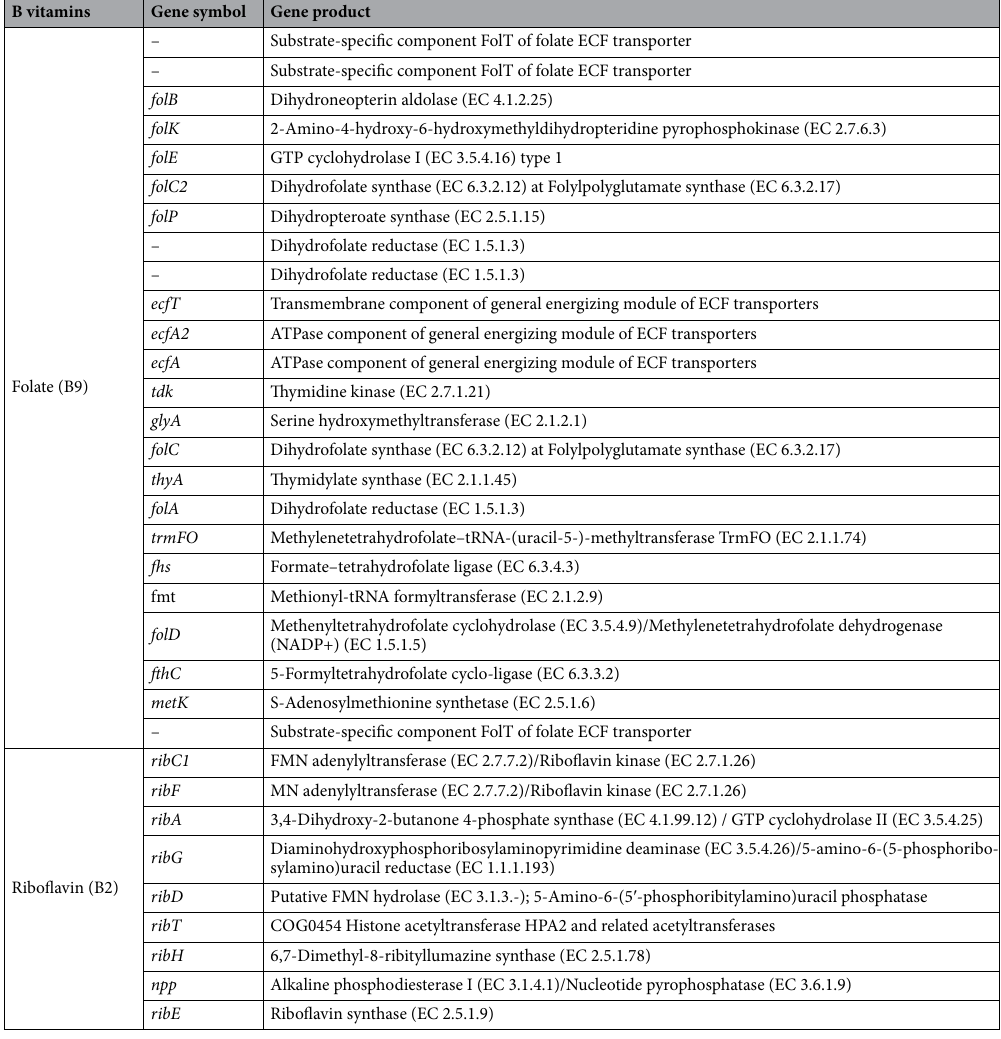
Table 5. List of putative genes in the L. plantarum ATCC 202195-A genome involved in B vitamin the import of short-chain FOS (scFOS) into the cytosol. The L. plantarum ATCC 202195-A genome also con- tains three gene clusters critical to the production of the short-chain fatty acid butyrate from acetyl-CoA. Biosynthesis of B complex vitamins. Evaluating the L. plantarum ATCC 202195-A genome for genes involved in the biosynthesis of B vitamins, revealed a complete gene cluster ( folA, folB, folC1, folC2, folD, folE, folK, folP and folQ ) that is involved in folate (vitamin B9) biosynthesis and utilization (Table 5). In contrast to L. plantarum strain WCFS1 38 , the L. plantarum ATCC 202195-A genome contains a complete riboflavin operon, including the ribA, ribB, ribH, ribE and ribG genes, required for riboflavin biosynthesis (Table 5). L. plantarum ATCC 202195-A also encodes genes involved in thiamine and biotin utilization and salvage; however, based on the genome sequences, the microbe appears incapable of de novo synthesis of either of these vitamins. Bacteriocins. The L. plantarum ATCC 202195-A genome encodes three plantaricin specific operons, includ- ing the regulator operon plnABCD, the bacteriocin operon plnEFI and the transport operon plnGHTUVW , which are required to produce the class IIb bacteriocins, plantaricin plnEF and plnA. Bacteriocins are a hetero- geneous group of bioactive bacterial peptides that act as antimicrobial agents against closely related susceptible bacterial species 39 . Similar to the reference strain L. plantarum WCFS1 38 , L. plantarum ATCC 202195-A also encodes the plantaricin immunity protein plnL , directly upstream from the regulatory operon.